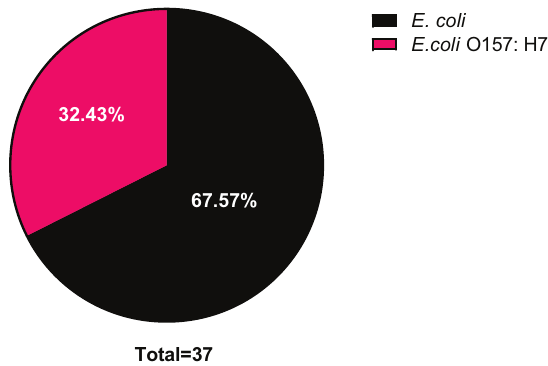
Figure 2 : Occurrence of E. coli O157:H7 in human diarrheal